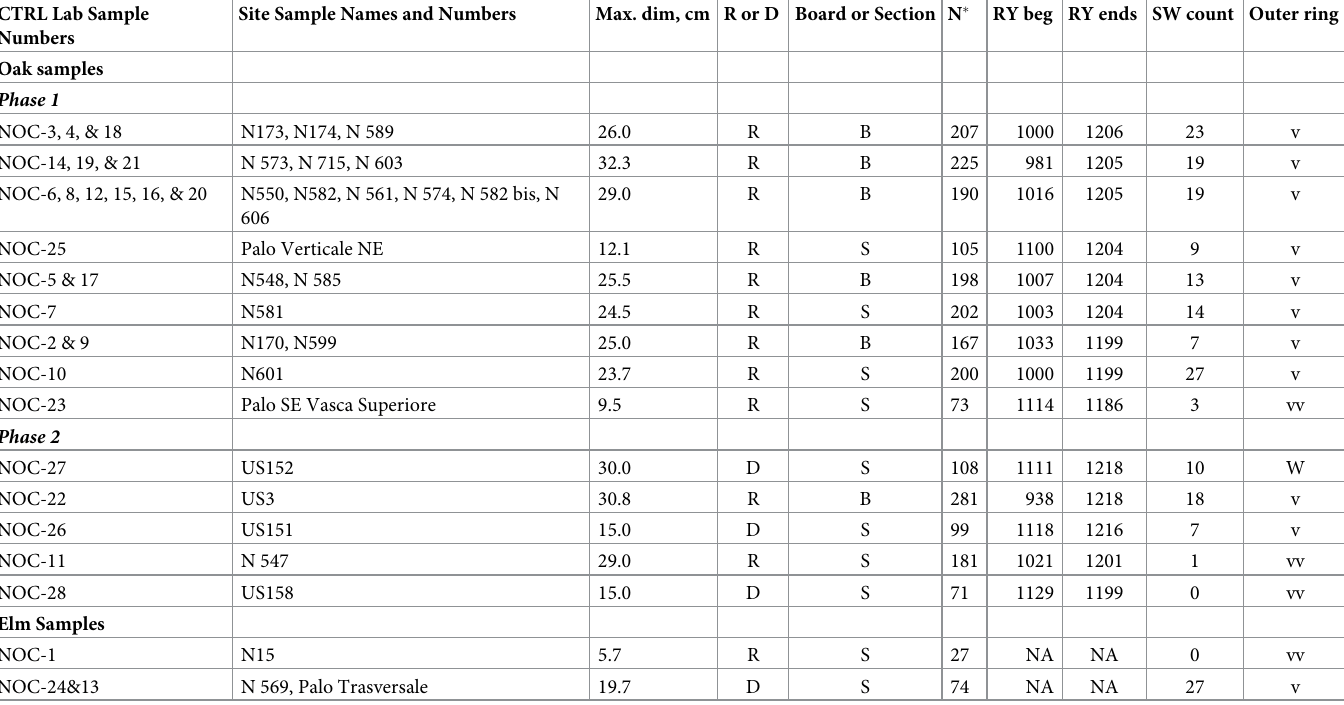
Table 2. Descriptions of the 14 trees represented by the 25 oak samples and the 2 elm trees represented by 3 samples. CTRL Lab Sample